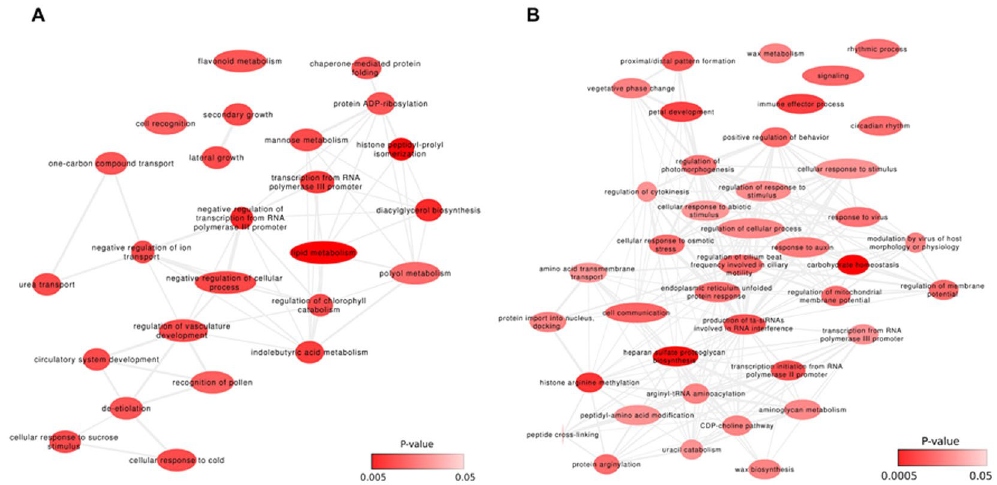
Figure 2. ( A ) The most frequently represented gene ontology (GO) terms of differentially alternatively spliced (DAS) genes in protonemata and gametophores. ( B ) The most frequently represented GO terms of DAS genes in protonemata and